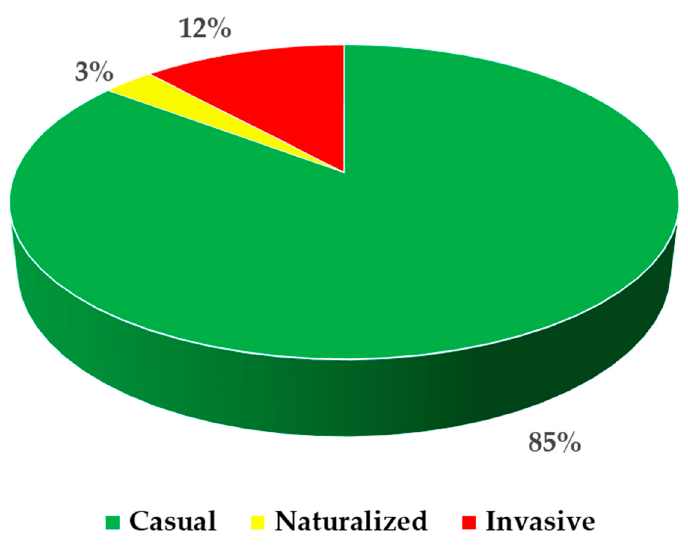
Figure 2. Current status of invasiveness of the 34 alien taxa recorded for the flora of Calabria (Southern Italy, Europe).